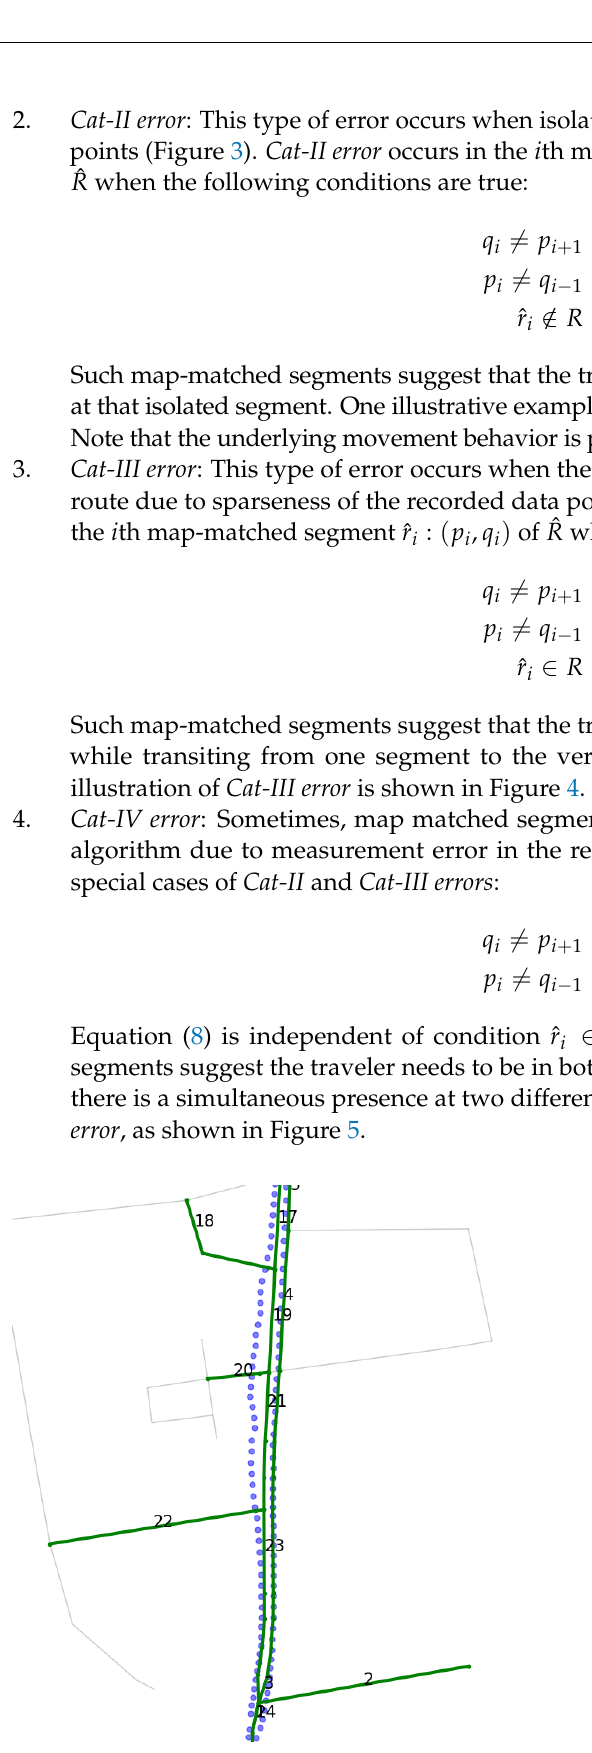
Figure 2. Cat-I error : hanging